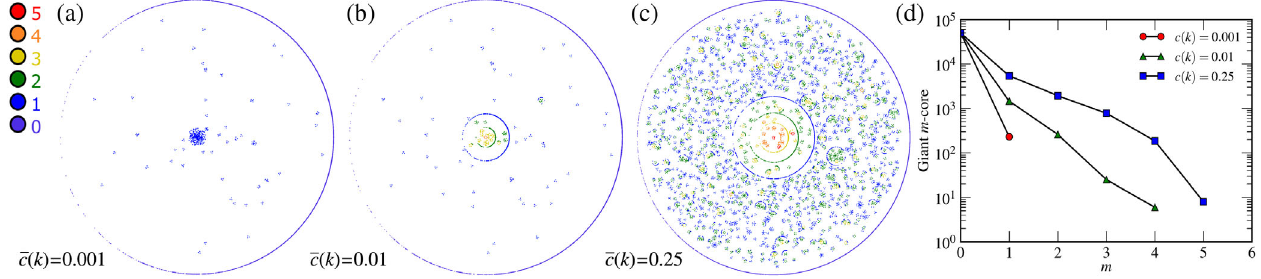
FIG. 3. (a – c) clustering m -core decomposition of three different networks with N ¼ 5 × 10 4 , γ ¼ 3 . 1 , and different levels of clustering, ¯ c ð k Þ ¼ 0 . 001 , 0.1, 0.25. The color code of a node represents its m coreness. For instance, nodes colored violet belong to the m 0 -core but not to the m 1 -core and are said to have m coreness of zero. The blue colored nodes belong to the m 1 -core but not to the m 2 - core and have m coreness of 1, etc. The visual representation is as follows. The outermost circle and its contents represent the m 0 -core and therefore the entire network. If we recursively remove all edges of multiplicity 0, we obtain the m 1 -core subgraph, which is contained within the m 0 -core. Nodes with no remaining connections do not belong to the m 1 -core, have m coreness of 0, and are located at the perimeter of the outermost circle. If the m 1 -core is fragmented into different disconnected components, these components are represented as nonoverlapping circles within the outermost one and with nodes of m coreness of 1 located in their perimeters [see, for instance, panels (b) and (c)]. The same process is repeated for each disconnected m 1 -core, which will contain a subset of the m 2 -core, and so on. Links between nodes are not depicted for clarity. (d) The size of the giant m -core as a function of m for the networks shown in panels (a –